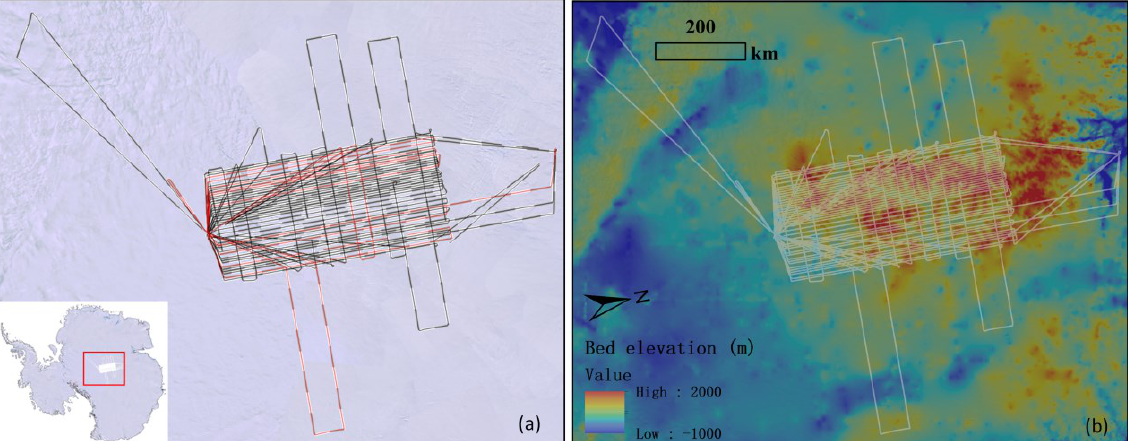
Figure 2. ( a ) The distribution map of the RES B-scope radargram data used in this study in the AGAP region. The red and black lines are designated as the distance between the two adjacent A-scopes, being 18 m and 30 m, respectively. ( b ) The flight lines overlaid the bed elevation data from BedMachine Version2 Antarctica [47].